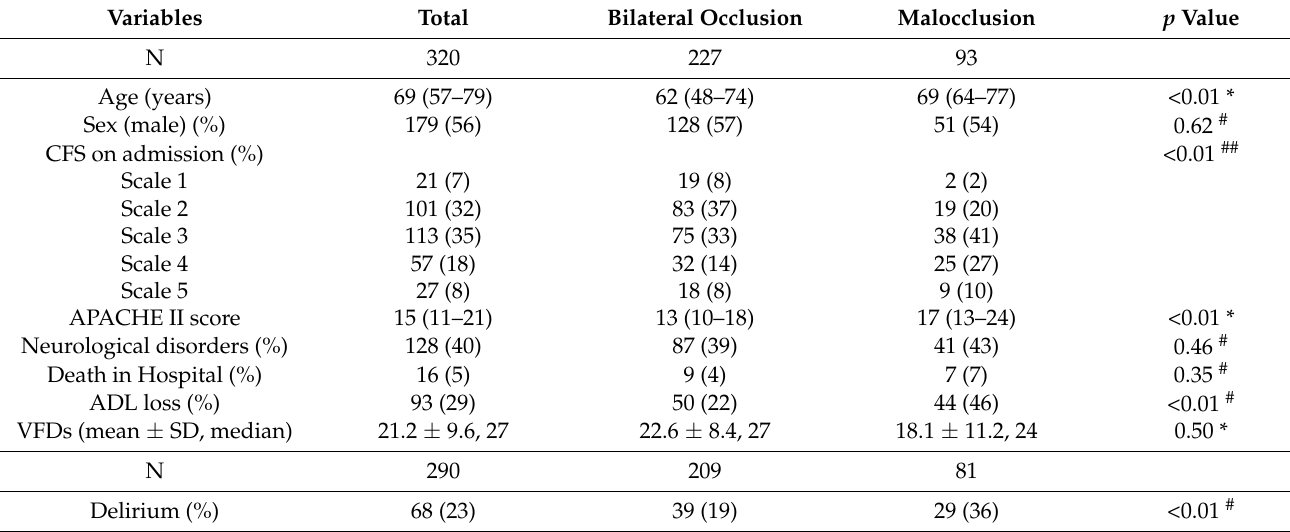
Figure 1. Study participants’ enrolment flow chart. Table 1. Baseline characteristics of the study population.